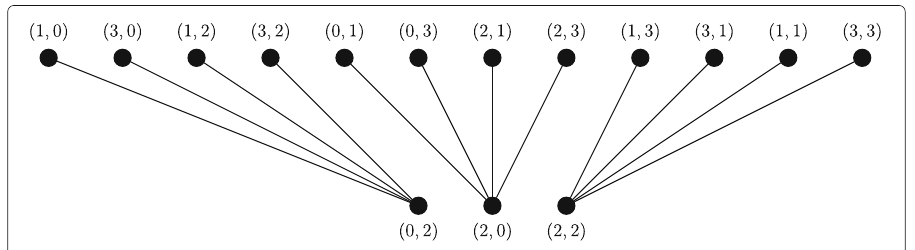
Fig. 3 Subgraph of the total dot product graph of Z 4 × Z